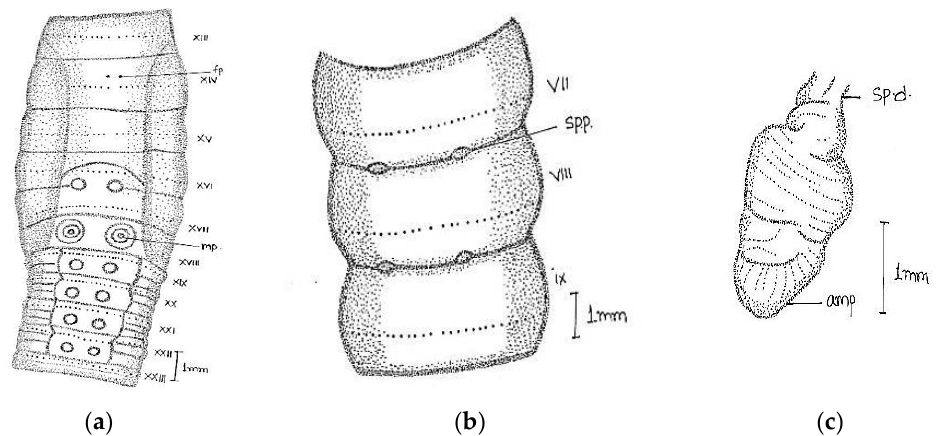
Figure 8. Camera lucida illustration of Megascolex ratus ( a ) genital region; ( b ) spermathecal pore; ( c ) spermathecae.